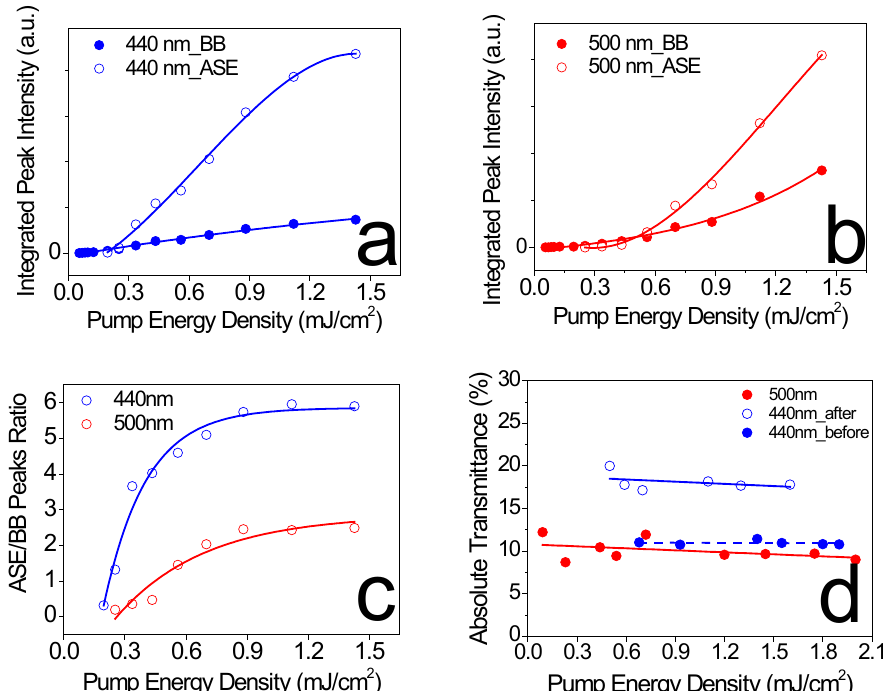
Figure 4. ( a , b ) Results of Gaussian fitting for integrated PL vs. the pump energy density for both broad band (BB) and ASE peaks under ( a ) 440 nm excitation and ( b ) 500 nm excitation; ( c ) plot of the ASE/BB peaks’ ratios under different pump energy densities; ( d ) absolute transmittance for the FAPbBr 3 /ms-TiO 2 /FTO sample vs. pump energy densities. Absolute transmittance rapidly increases from the level of blue solid circles to that of blue open circles under 440 nm illumination, as indicated in the text.